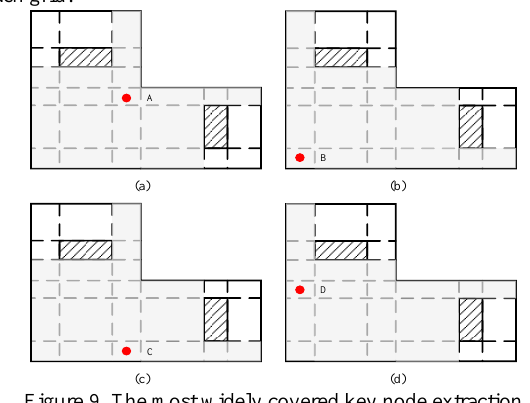
Figure 9. The most widely covered key node